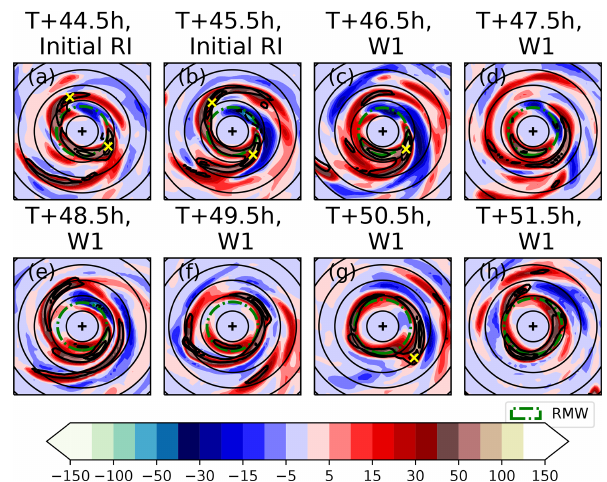
Figure 13. Diabatic heating (Kh − 1 shading) for height 4963m be- fore and during the first weakening phase W1. Vertical velocity con- tours in intervals of 2ms − 1 . Yellow crosses indicate the location of the maximum local perturbation vertical velocity at the same level for any isolated regions of deep rotating convection as determined by criteria adapted from Smith and Eastin